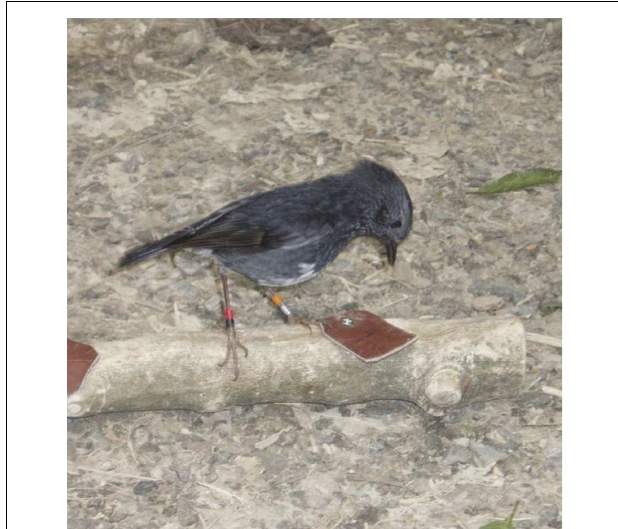
FIGURE 1 |A robin makes his choice by pulling a flap attached to the apparatus and retrieving the